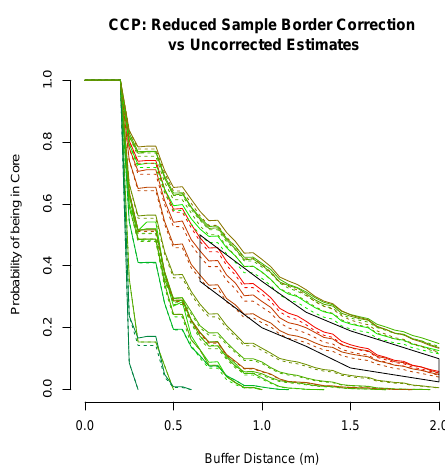
Figure 8: The reduced sample CCP estimates (solid lines) and uncorrected CCP estimates (dashed lines). At these small buffer distances (relative to window size) border cor- rection has minor impact. Note that the uncorrected esti- mates are lower because they have implicitly assumed that no tree canopy existed outside the observation